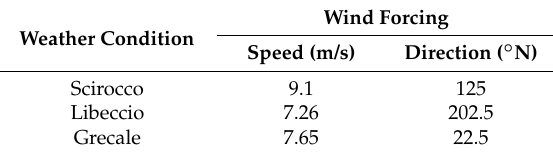
Table 2. Weather conditions selected to analyse the spatial distribution of FT in each harbour